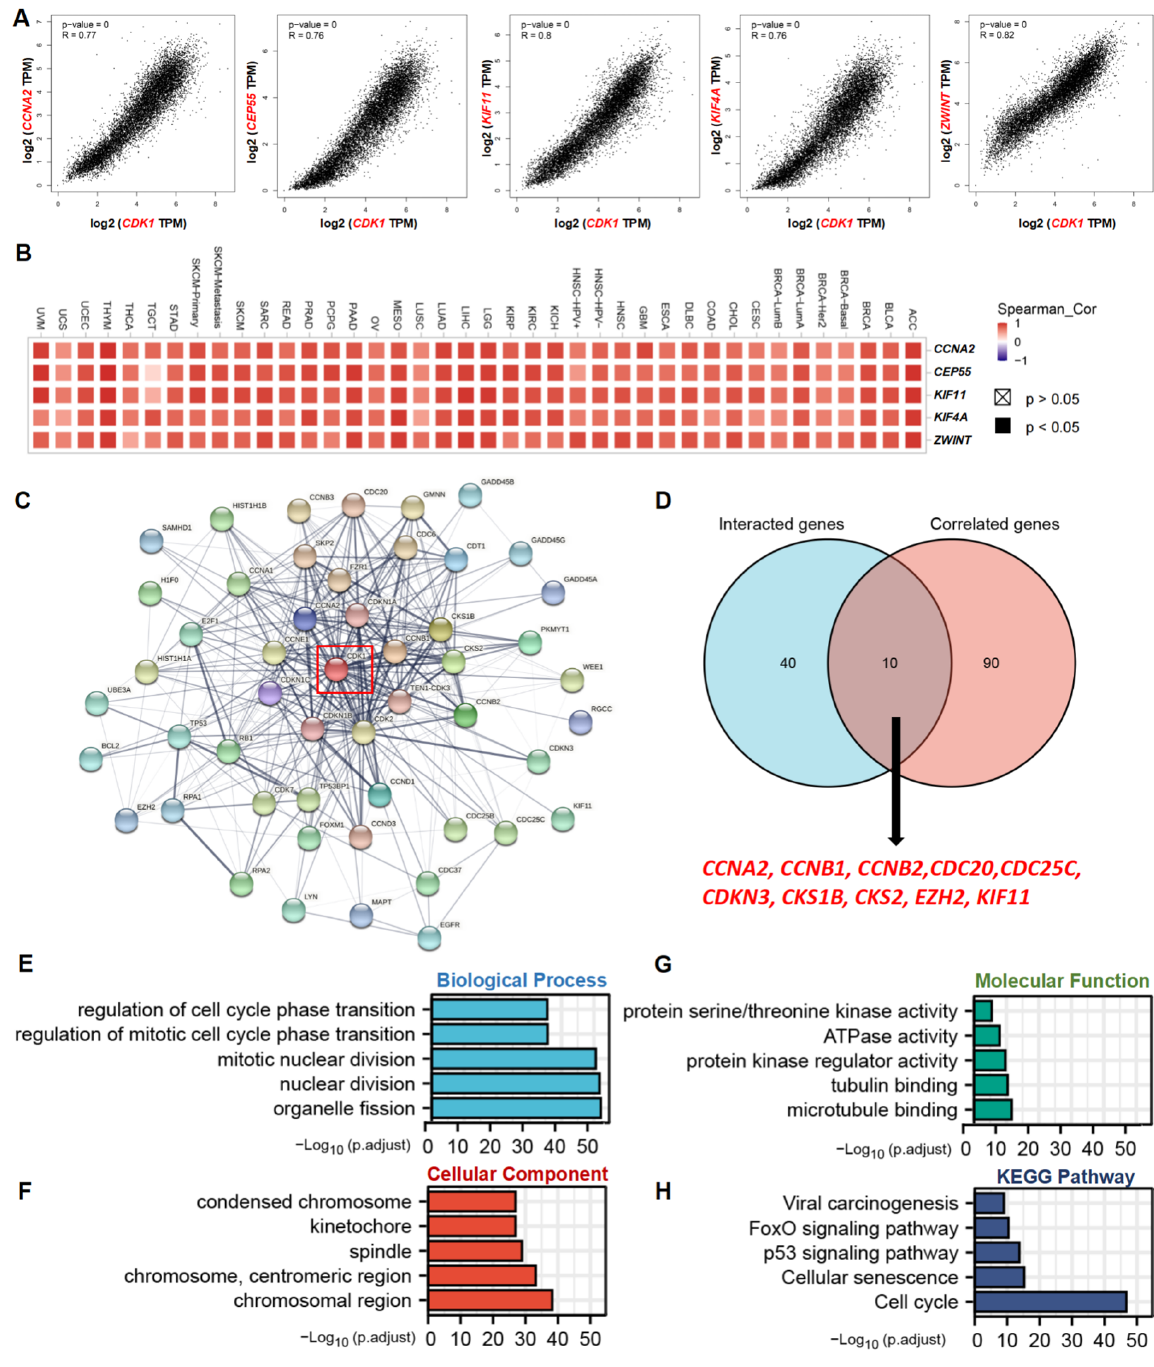
Figure 5. CDK1 -related gene network, GO enrichment analysis, KEGG pathway analysis, and protein–protein interactions. ( A ) Top 5 CDK1 -correlated genes in TCGA database, CCNA2 , CEP55 , KIF11 , KIF4A , and ZWINT , Pearson’s correlation coefficients. ( B ) The heatmap reveals that CDK1 expression was positively correlated with these five genes in all tumor types according to purity-adjusted partial Spearman’s rho values. ( C ) PPI network of 50 experimentally verified CDK1-interacted proteins. ( D ) An intersection analysis of the CDK1 -interacted and CDK1 -correlated genes. ( E – G ) The correlations between CDK1 and biological processes, cellular components, and molecular functions according to GO enrichment analysis. ( H ) KEGG pathway analysis was performed based on the CDK1 -interacted and CDK1 -correlated